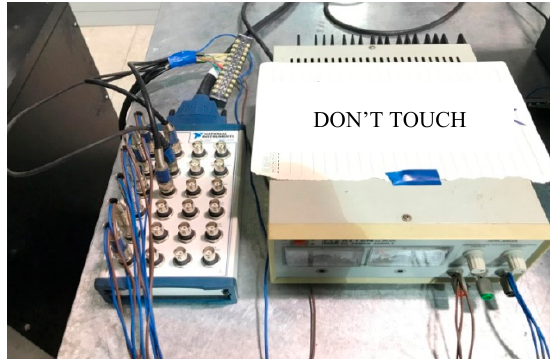
Figure 8. Acquisition device — NATIONAL INSTRUMENTS BNC-2111.